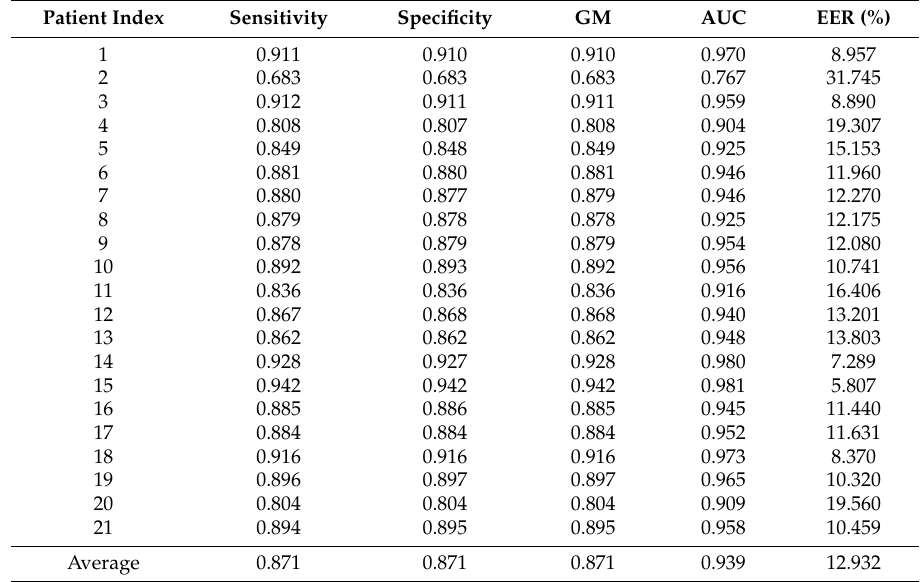
Table 8. Results per patient of the CNN-LSTM with three previous windows using LOSO